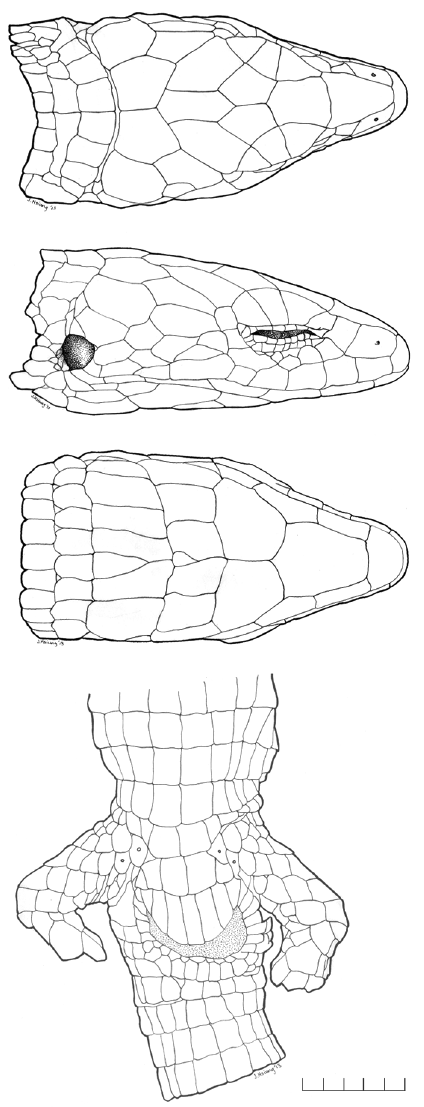
Figure 1. Oreosaurus serranus sp. n. (holotype, ROM 53608 [70.4 mm SVL]). Dorsal, lateral and ventral views of the head, and ventral view of the pelvic